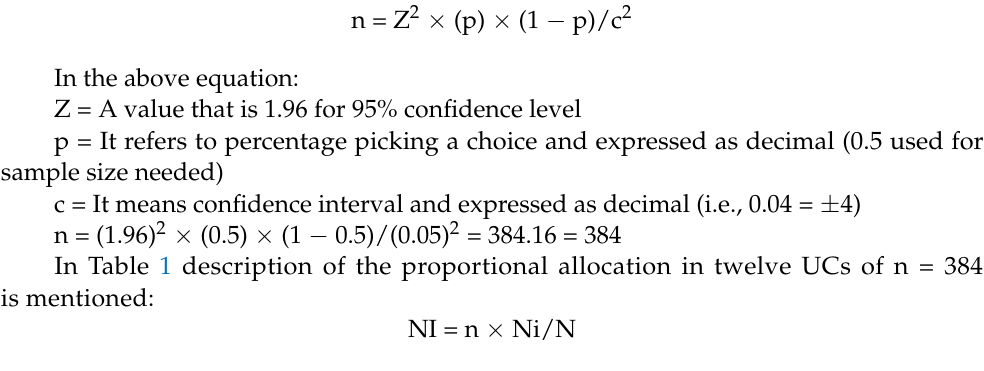
Table 1. Sample size proportional distribution from sub-districts to UCs in the District.